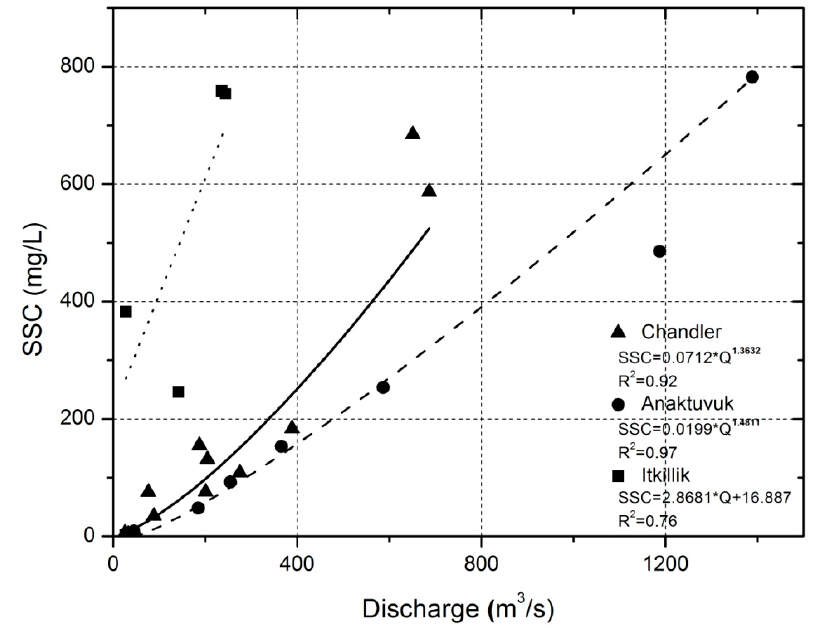
Figure 4. Relationships between discharge and SSC calculated from integrated samples. Anaktuvuk n = 7; Chandler n = 10; Itkillik n = 4.